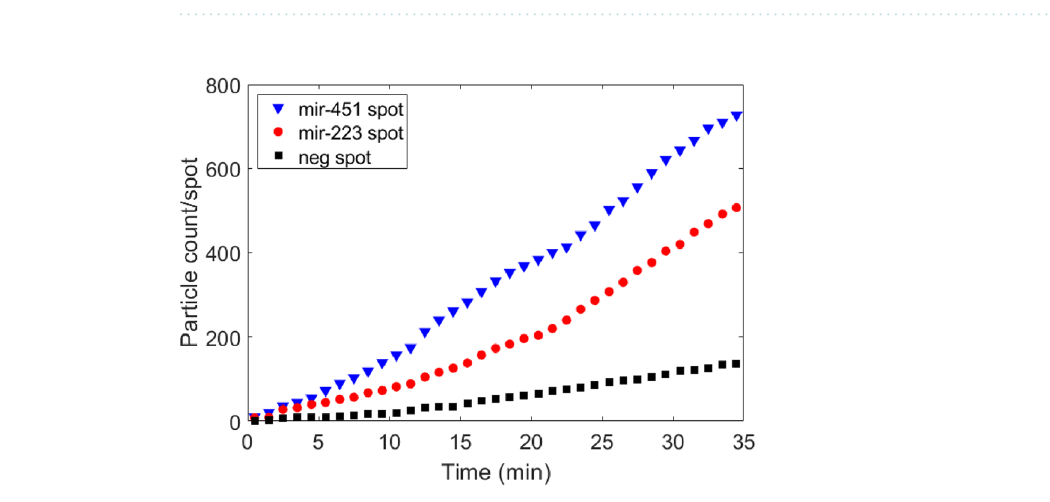
Figure 5. Cumulative number of binding events on each spot type throughout the incubation in a multiplexed